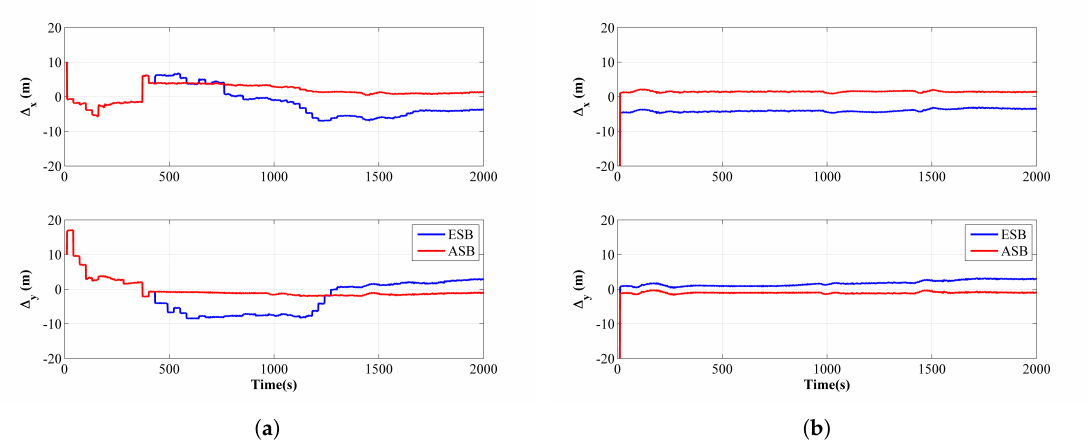
Figure 13. Position component errors of the ESB and the ASB algorithms using field data with unknown Q k : ( a ) Filter; ( b ) RTS